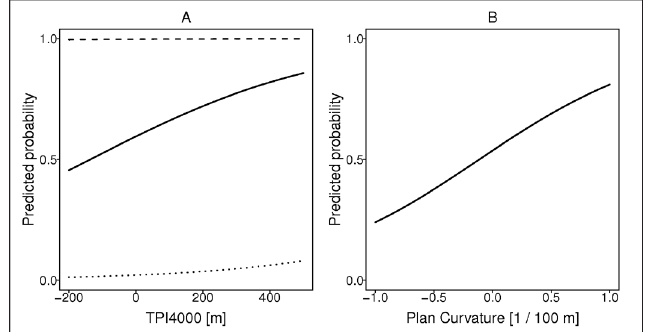
Figure 9: Response curves illustrating the predicted probability of occurrence of a SaS dependent on (A) TPI4000 (solid line: TPI250 = median, dashed line: TPI250 = max, dotted line: TPI250 = min) and (B) CURVATURE (with the other explanatory variables set to median or